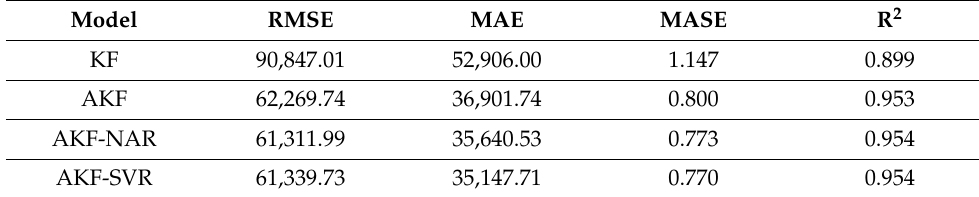
Table 1. Results for strawberry time series: 2019–2020 (weekly).